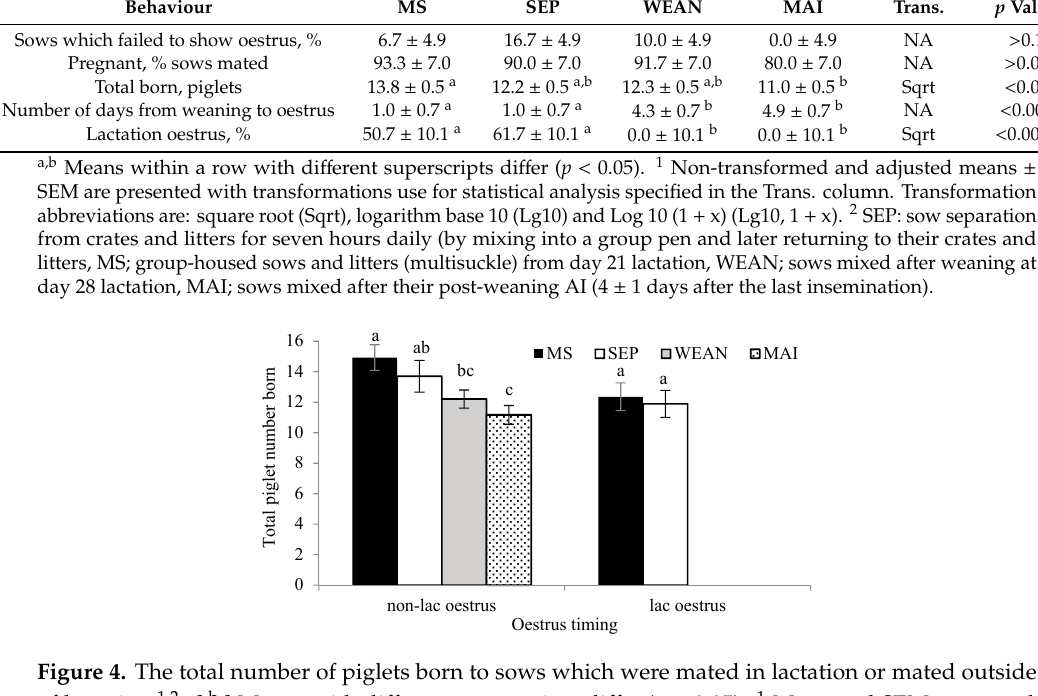
Table 5. E ff ect of treatment on reproduction in di ff erent housing systems from lactation in sows 1,2 . Behaviour MS SEP WEAN MAI Trans.